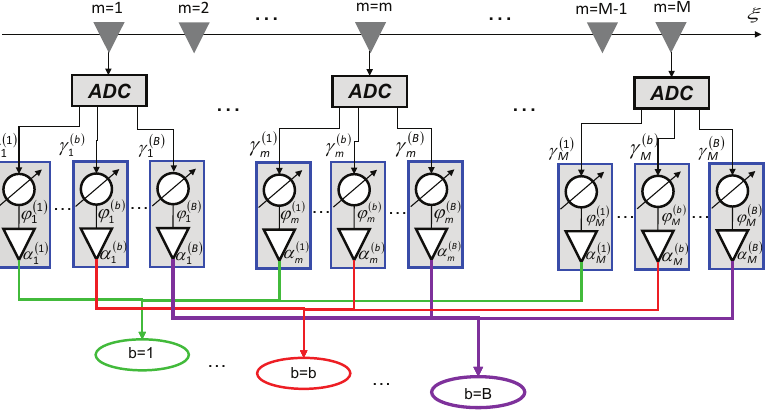
Figure 3. Logical scheme of the DBF network of the single plank that generates B independent radiation